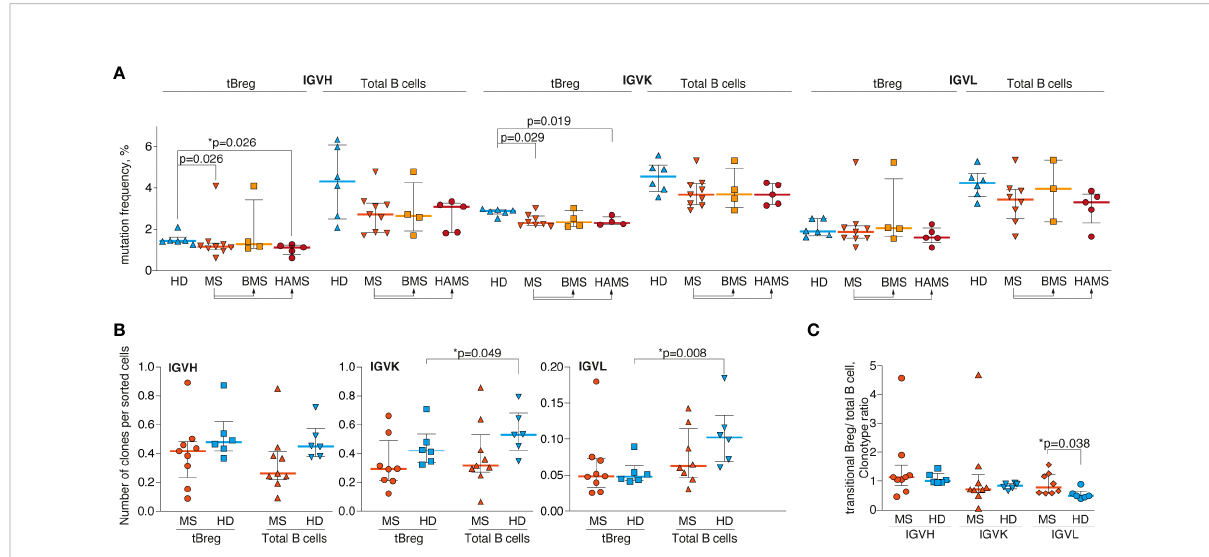
FIGURE 2 Delayed maturation of CD24 high CD38 high transitional B lymphocytes in the MS patients. (A) Mutation frequency for V H , V k , and V l genes; (B) the number of unique clonotypes per sorted cells; and (C) the tBreg/total B cell clonotype ratio of the total blood B cells and CD24 high CD38 high transitional Bregs from the multiple sclerosis patients (MS) and healthy donors (HD). Mutation frequency refers to the percentage of clonotype sequence different from the corresponding germline V- and J-segment sequences excluding CDR3 region. BMS denotes benign multiple sclerosis, HAMS is highly active multiple sclerosis. Bar and line plots represent a median and interquartile range. Statistical signi fi cance of the differences between donor groups was assessed using the Mann-Whitney test (A, B) and ratio paired T -test (C) . p -values <.05 after correction for multiple comparisons were considered statistically signi fi cant and designated with